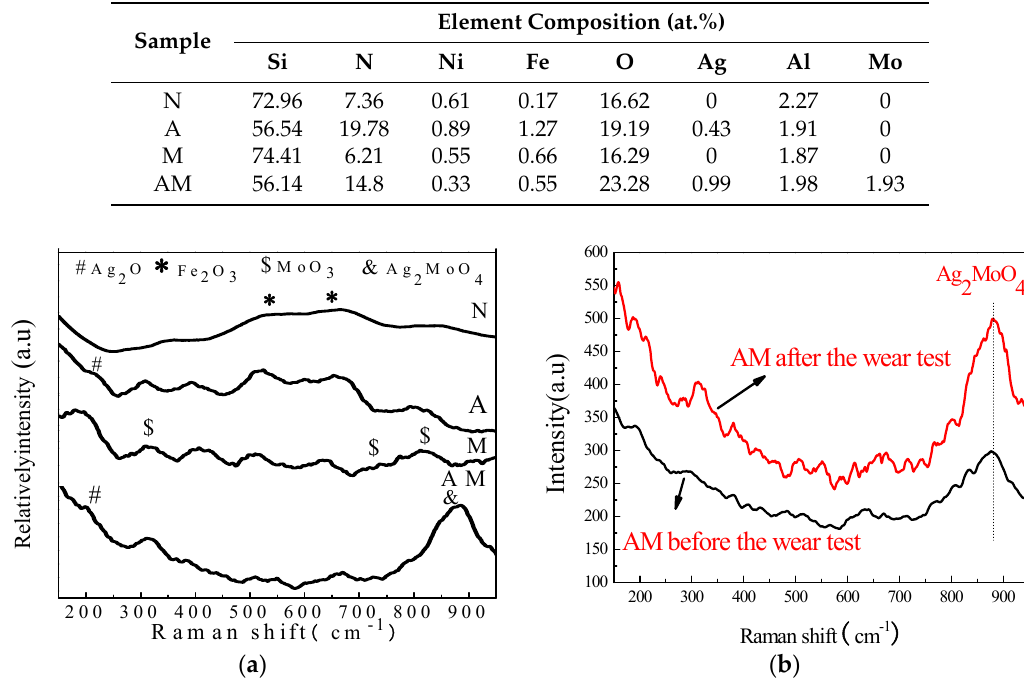
Figure 9. ( a ) Raman spectra of the worn surfaces for all samples after the wear test; and ( b ) Raman spectra before and after the wear test for AM.